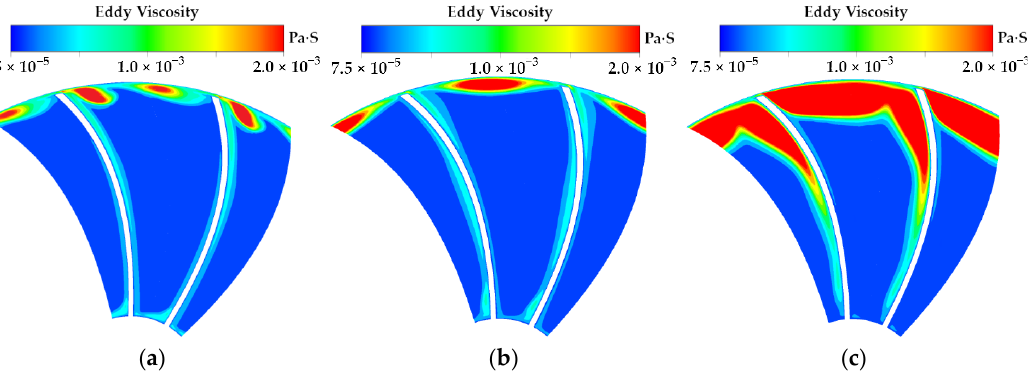
Figure 4. Eddy viscosity distributions at the cross-section of about 15% chord length under three working conditions. ( a ) S1: large margin point; ( b ) S2: design point; ( c ) S3: quasi ‐ stall point.